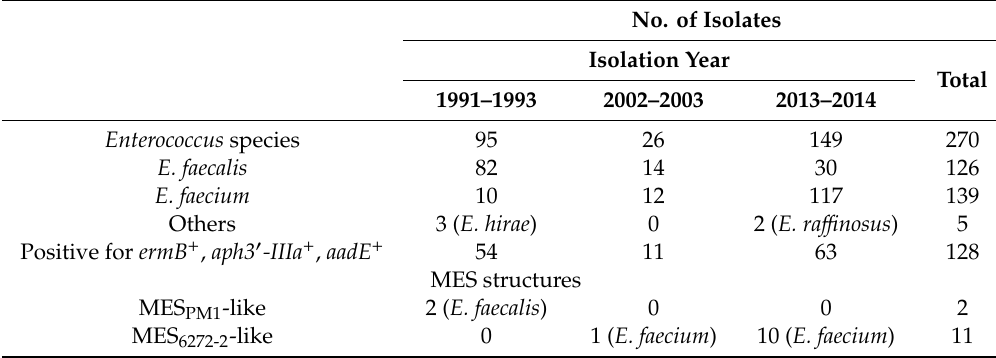
Table 2. Summary of the bacterial strains collected in this